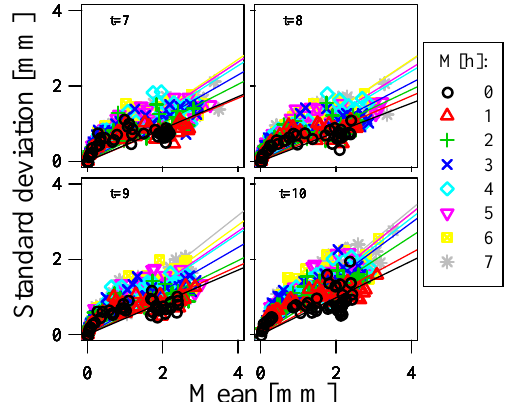
Fig. 11. Sensitivity analysis. Scatter plot of ˆ µ J,t and ˆ σ J,t with fit- ted coefficients of variations (CV J ) for four time steps, an advec- tion speed of 6kmh − 1 and a catchment area of 4900km 2 . Different points in each panel are for individual points (pixels) of the catch- ment.